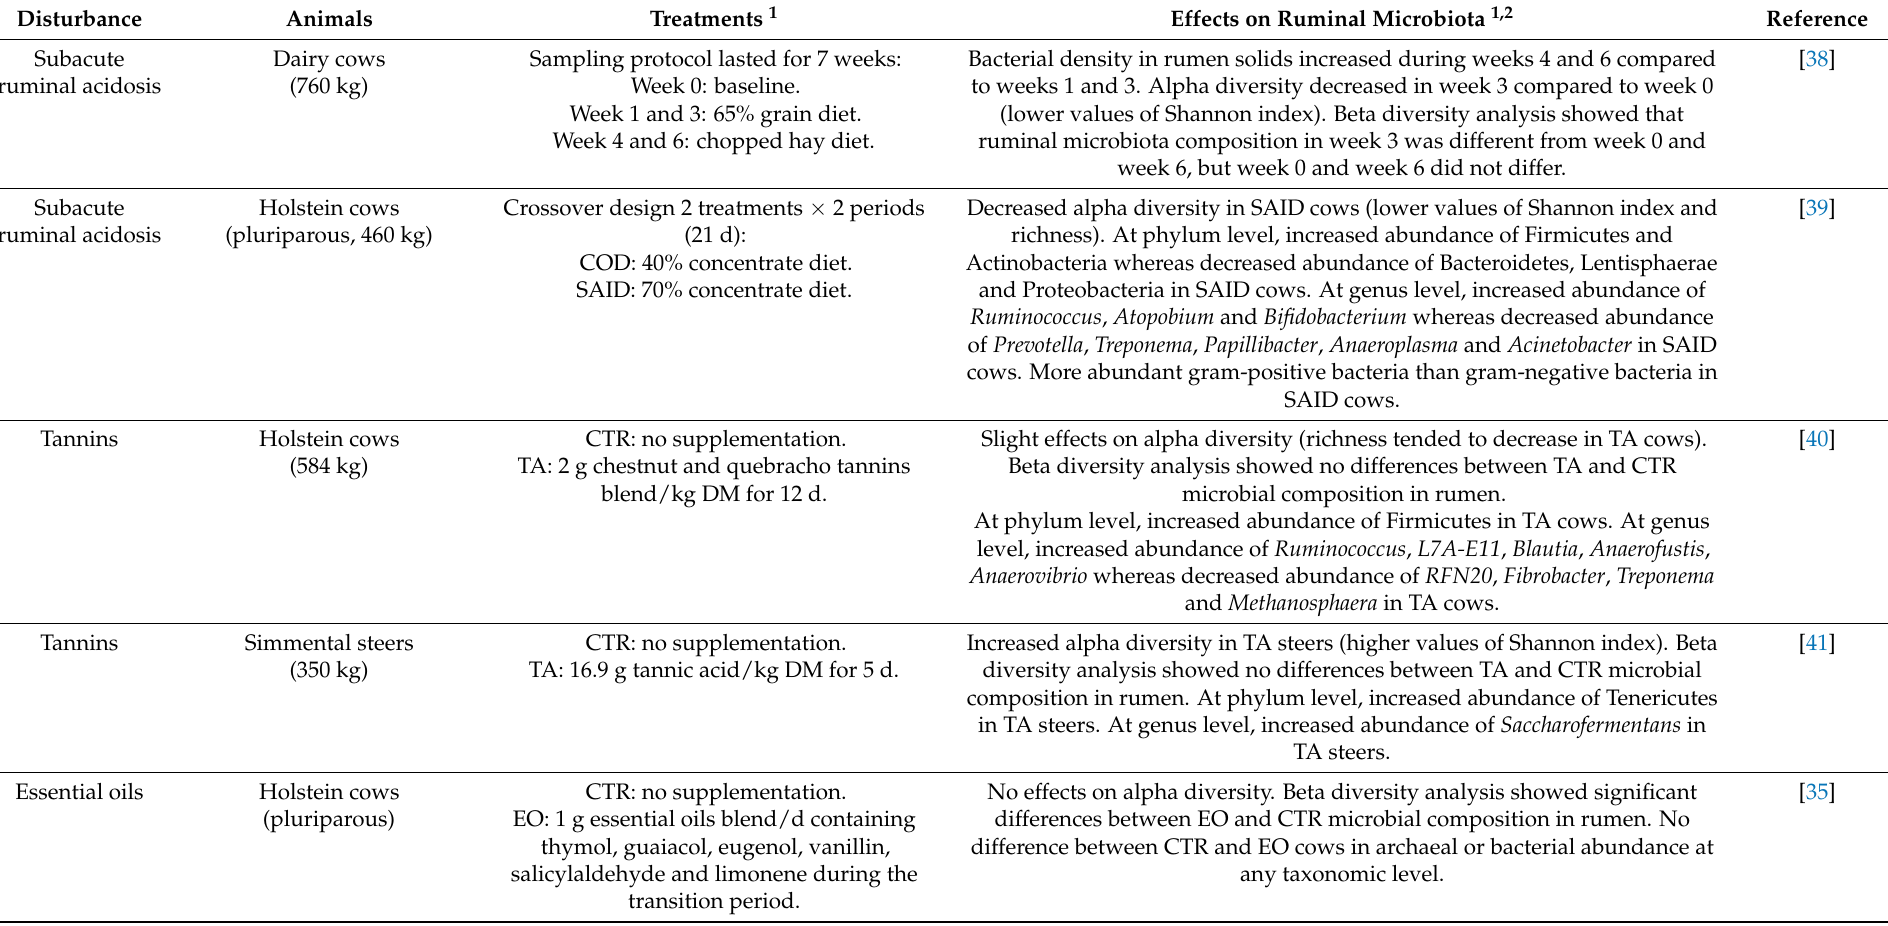
Table 2. Main effects of press disturbances on ruminal microbiota (bacteria and